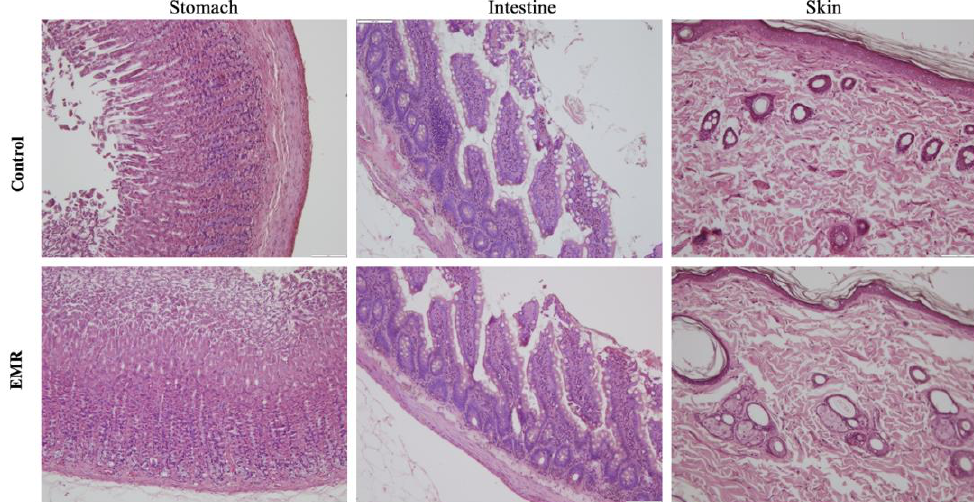
Figure 7. The effect of 150 kHz IF EMR on the histopathology of the stomach, intestine (jejunum), and skin of rats in the control and EMR groups after 2 months of whole-body exposure. The mucosal epithelium and glands of the stomach appeared normal. The lamina propria appeared to be healthy. The intestine showed a typical mucosa with enterocytes and goblet cells lining the villi. The epidermis and dermis of the skin appeared normal with typical glands (H&E × 200).